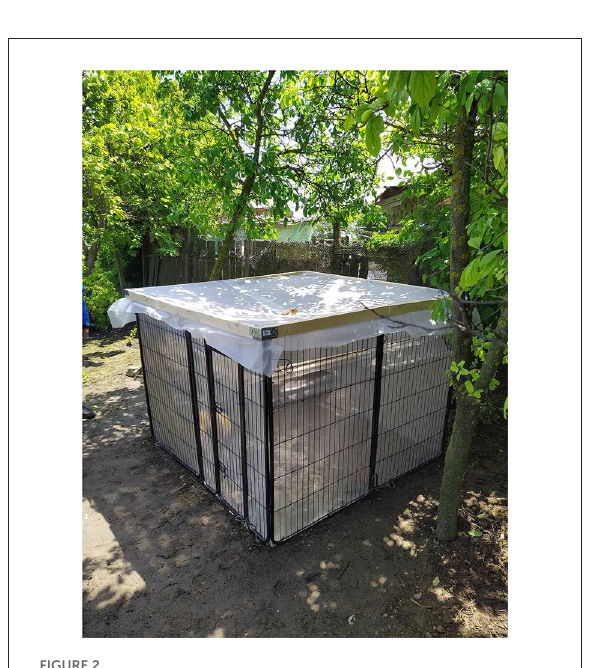
FIGURE2 One of the pig cages used in the experiment (pigs not yet included). The entry trap slit can be seen on the front right panel. Collectors entered the cage through a small door, as can be seen on the front left panel, by carefully opening it and closing it immediately upon entry, so no insects would fly